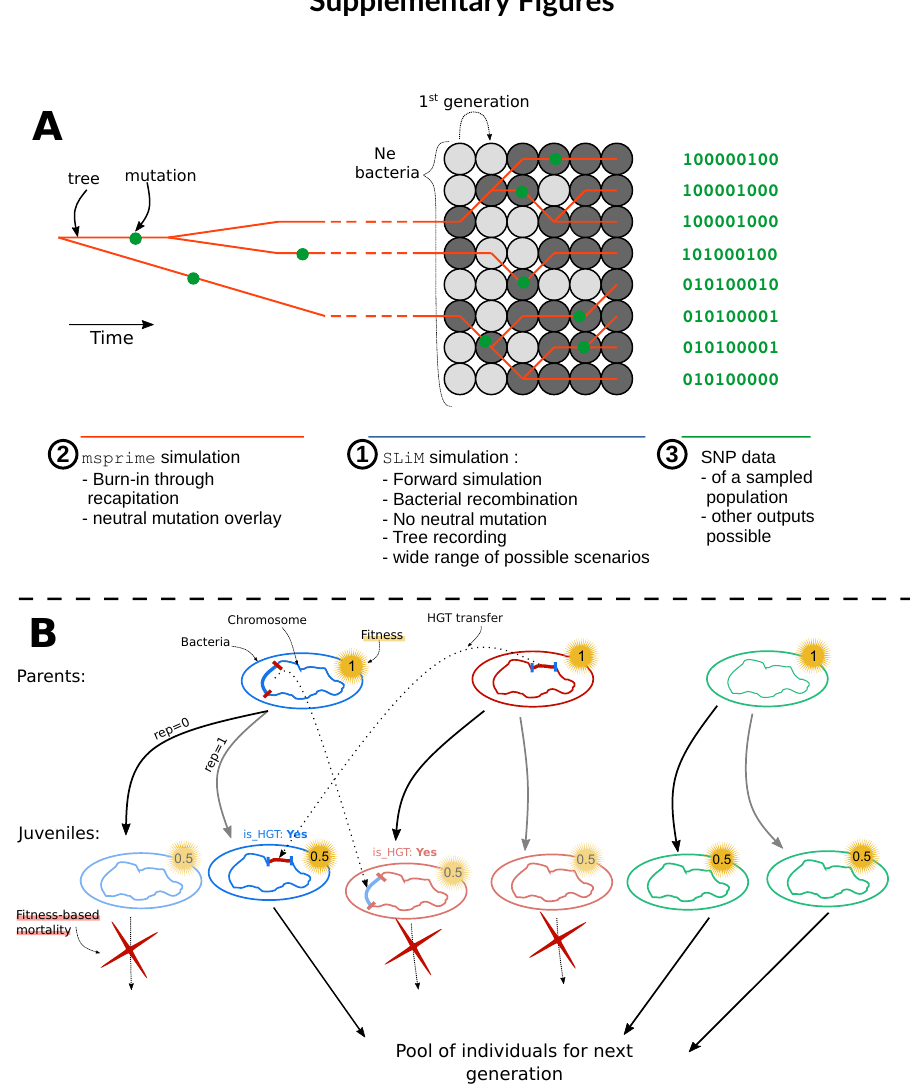
Figure S1 – Schema of the nonWF simulation process described in this study. This schema is a visual companion to section 2.2 Simulation protocol, and is not self